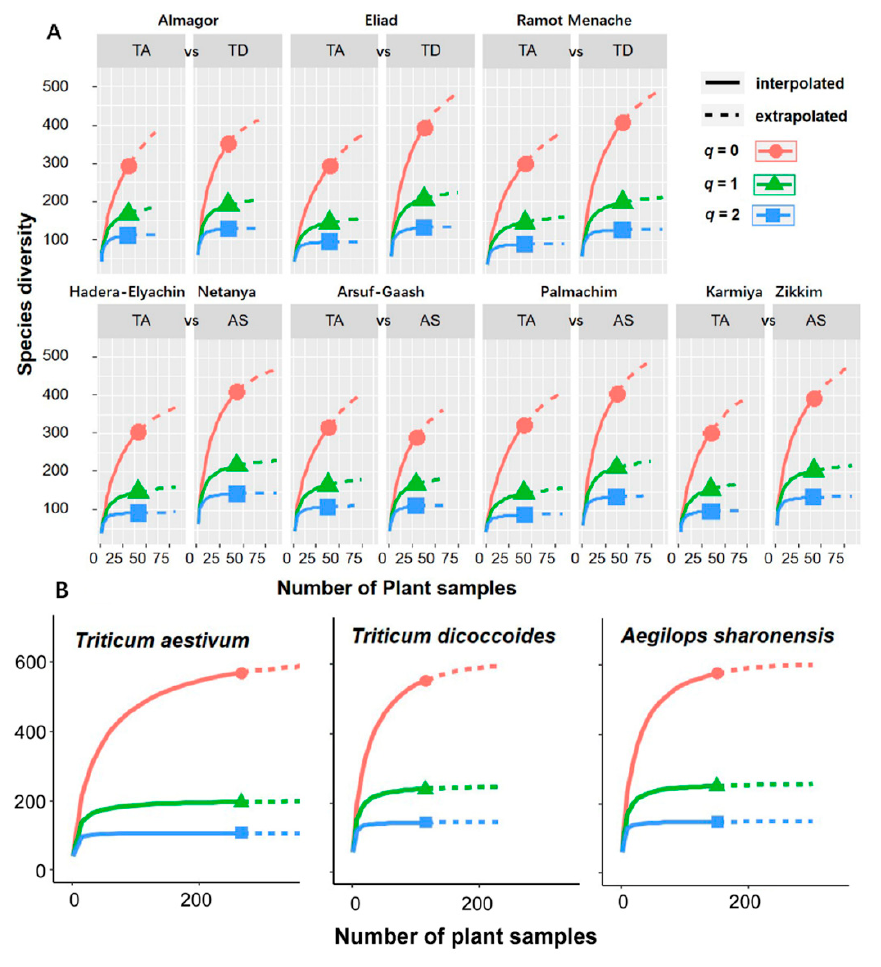
Figure 5. FECs from the wild plant species are richer and more diverse that wheat FECs. The sample-size based rarefaction and extrapolation of Hill numbers of order q are shown for the FECs in each of the 14 sites ( A ) and for pooled populations of each of the host plants ( B ). TA— T. aestivum , AS— Ae. sharonensis, TD— T. dicoccoides . Red—richness ( q = 0), Green—exponential of Shannon entropy ( q = 1), Blue—inverse of Simpson concentration ( q = 2).